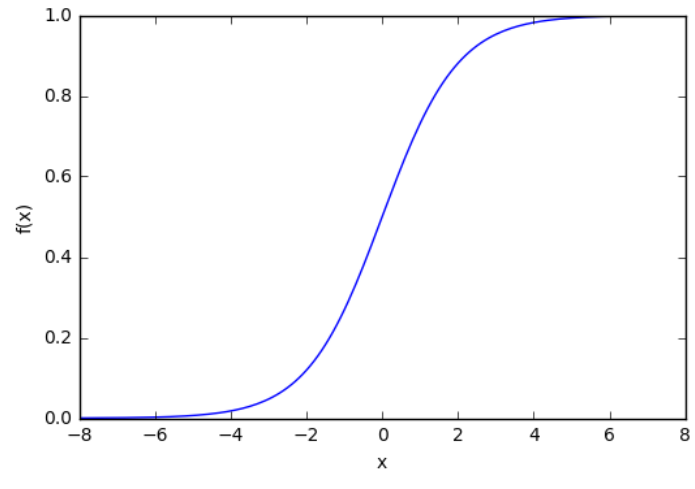
Figure 7. The plot of a sigmoid function.